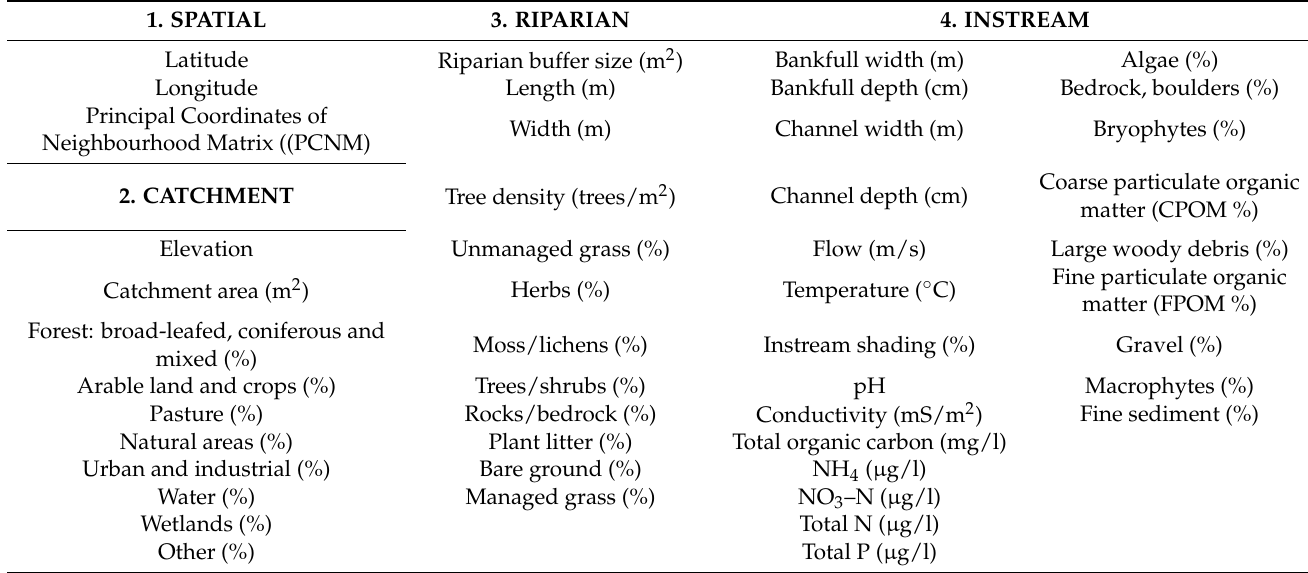
Table 1. List of environmental (explanatory) variables used to assess the difference in the structure of the macroinvertebrate communities between buffered and unbuffered